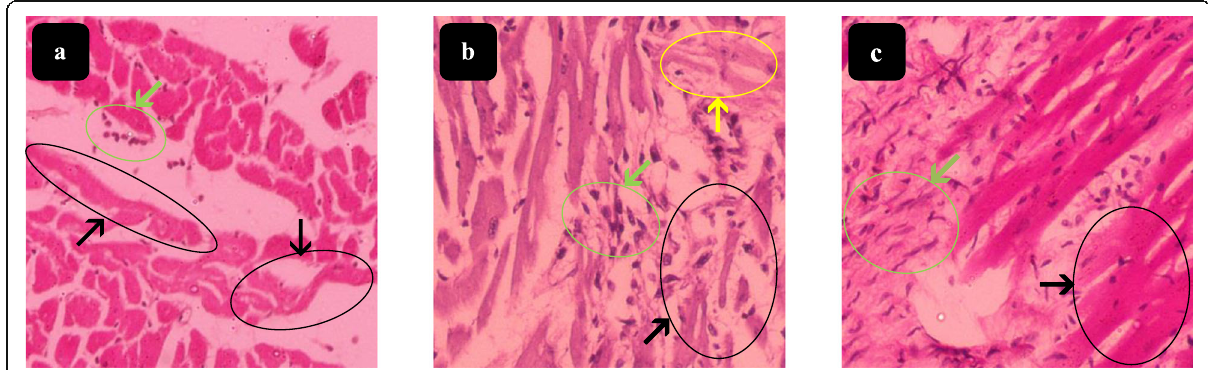
Fig. 2 Cardiac histology of ISO administered rat with MI (Group 2): ( a ) sacrificed on 31st day exerted distorted myofibrils (pointed with black arrow) and nuclei aggregation (pointed with green arrow), ( b ) sacrificed on 46th day also showed pronounced inflammation (pointed with yellow arrow) in cardiomyocytes, damaged myofibrils (pointed with black arrow) and nuclei aggregation (pointed with green arrow), (c) sacrificed on 61st day depicted less pronounced myocardial damage with deformed myofibrils (pointed with black arrow) and nuclei aggregation (pointed with green arrow)